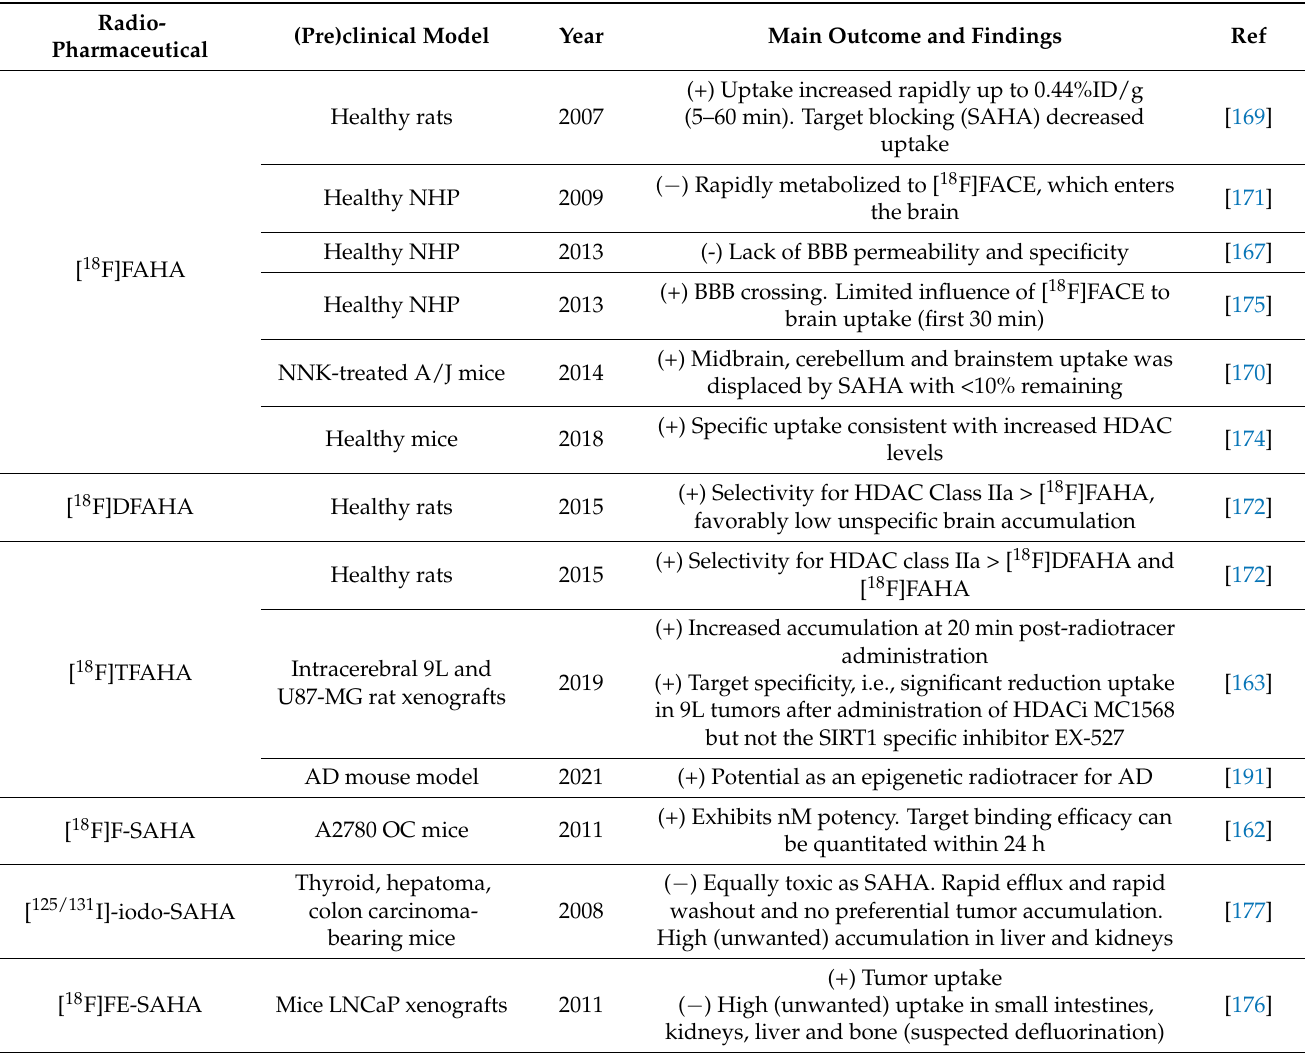
Table 2. Preclinical development of HDAC